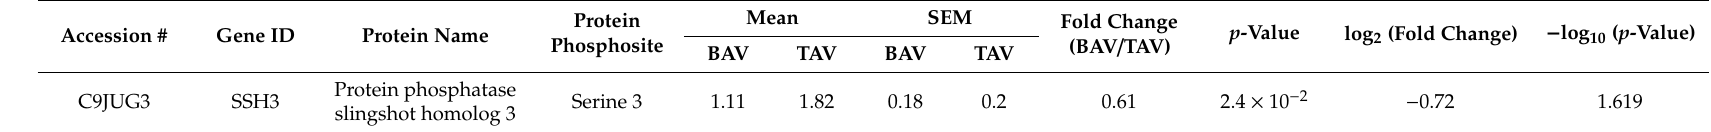
Table 4. Significantly changed phosphoproteins in the aortas of neonatal BAV patients compared to TAV patients.